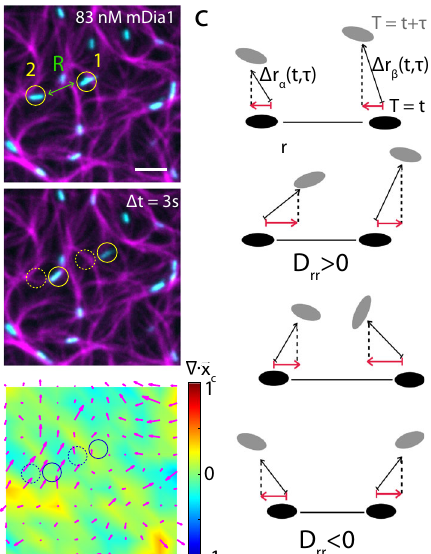
myosin thick fi laments in mDia1 and Arp 2/3-nucleated F-actin networks over r = 3 – 20 μ m. Hollow triangles show data without Ni. Gray dashed lines show slope of − 1.Inset:2 μ mbeadsinglycerol/water(1:3)(black). g C rr forSMM(blue)andSKMM (red) thick fi laments in non-nucleated F-actin networks. Gray dashed lines show slope of − 1 ( N = 3 independent experiments for each condition, N pair >1×10 6 . Source data are provided as a Source Data fi